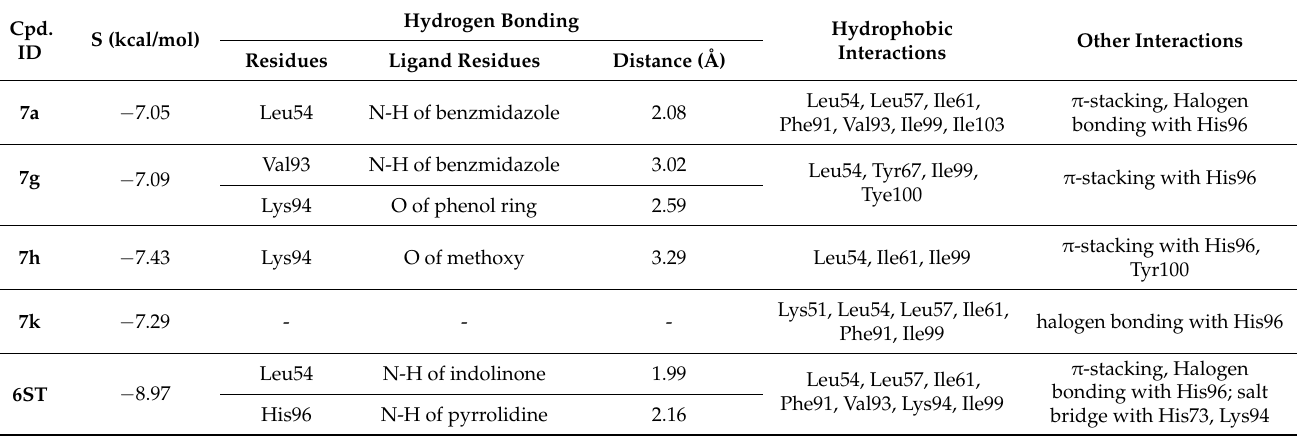
Table 3. Docking scores and network of interactions formed between the ligands and residues of MDM2.